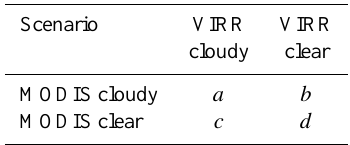
Table 5. The notations used for the definitions of POD, FAR, and HR scores.